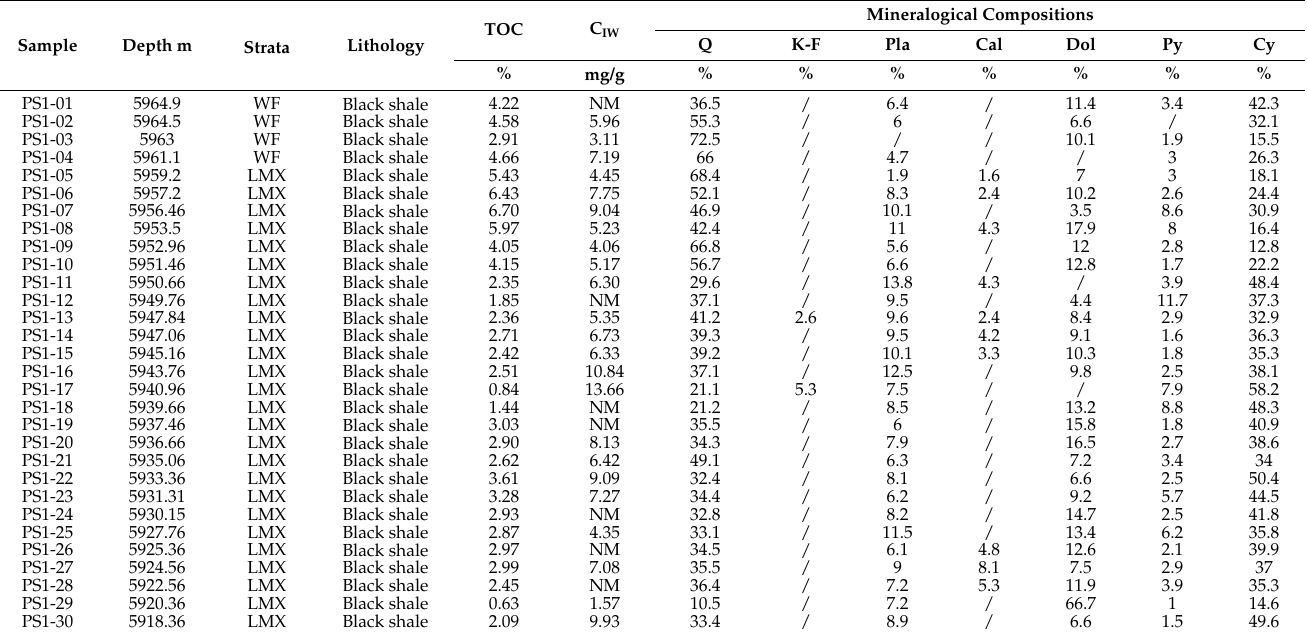
Table 1. Basic information, TOC content, C IW content, and mineralogical composition of the studied shale samples from Well